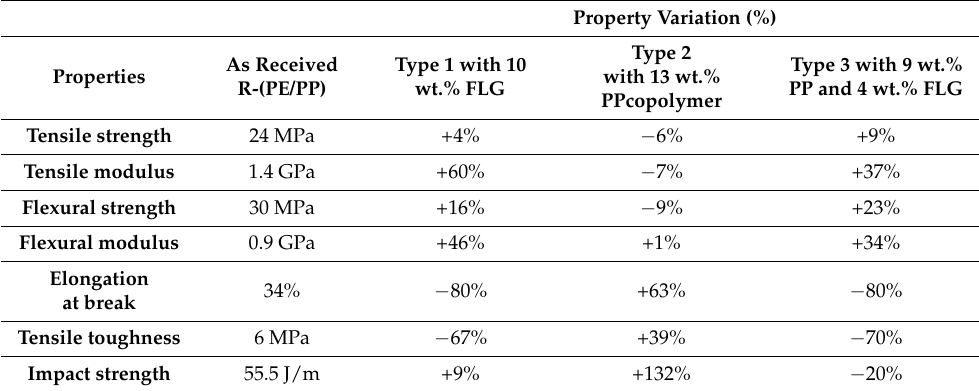
Table 3. Mechanical property variation (%) in compounds showing a significant change in properties compared to the neat